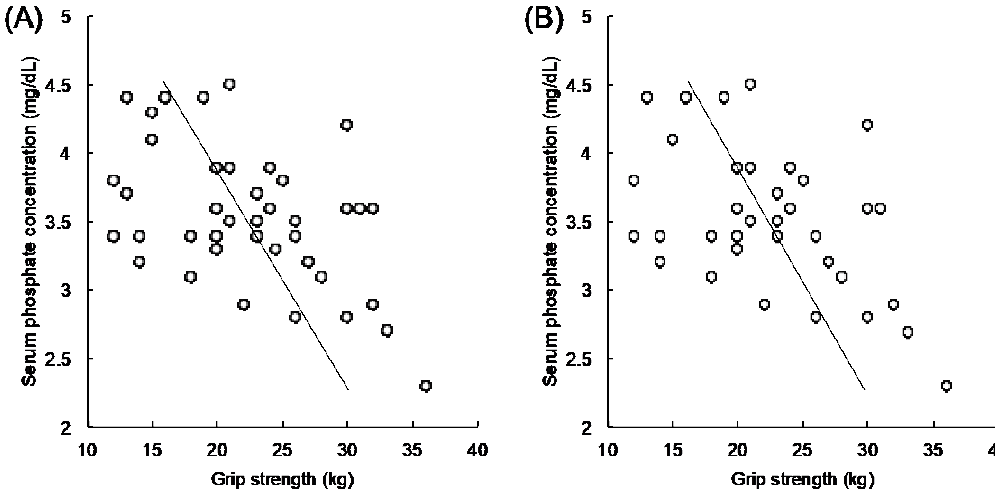
Figure 1. Correlation analysis between serum phosphorus concentration and hand grip strength. The vertical axis indicates the serum phosphorus concentration (mg / dL). The horizontal axis indicates grip strength (kg). Any correlations seen were validated using Pearson’s correlation coe ffi cient. An inverse correlation is observed between the serum phosphorus concentration and hand grip strength in ( A ) total patients ( r = − 0.501, 95% confidence interval: − 0.700, − 0.228, p < 0.001), and ( B ) patients with eGFR ≥ 30 mL / min / 1.73 m 2 ; higher hand grip strength, n = 18 and lower hand grip strength, n = 18 ( r = − 0.501, 95% confidence interval: − 0.712, − 0.207, p = 0.002). eGFR, estimated glomerular filtration rate.